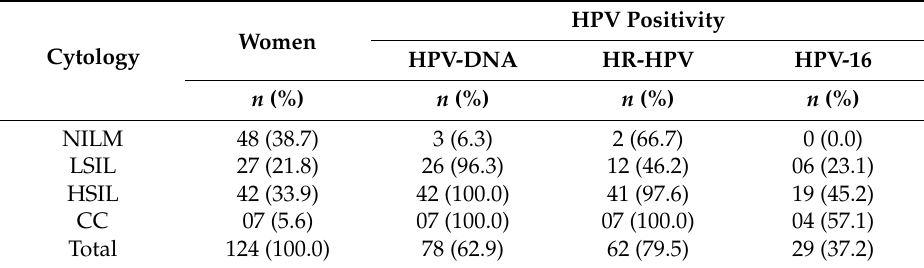
Table 1. Frequency of HPV infection grouped by cytological findings.